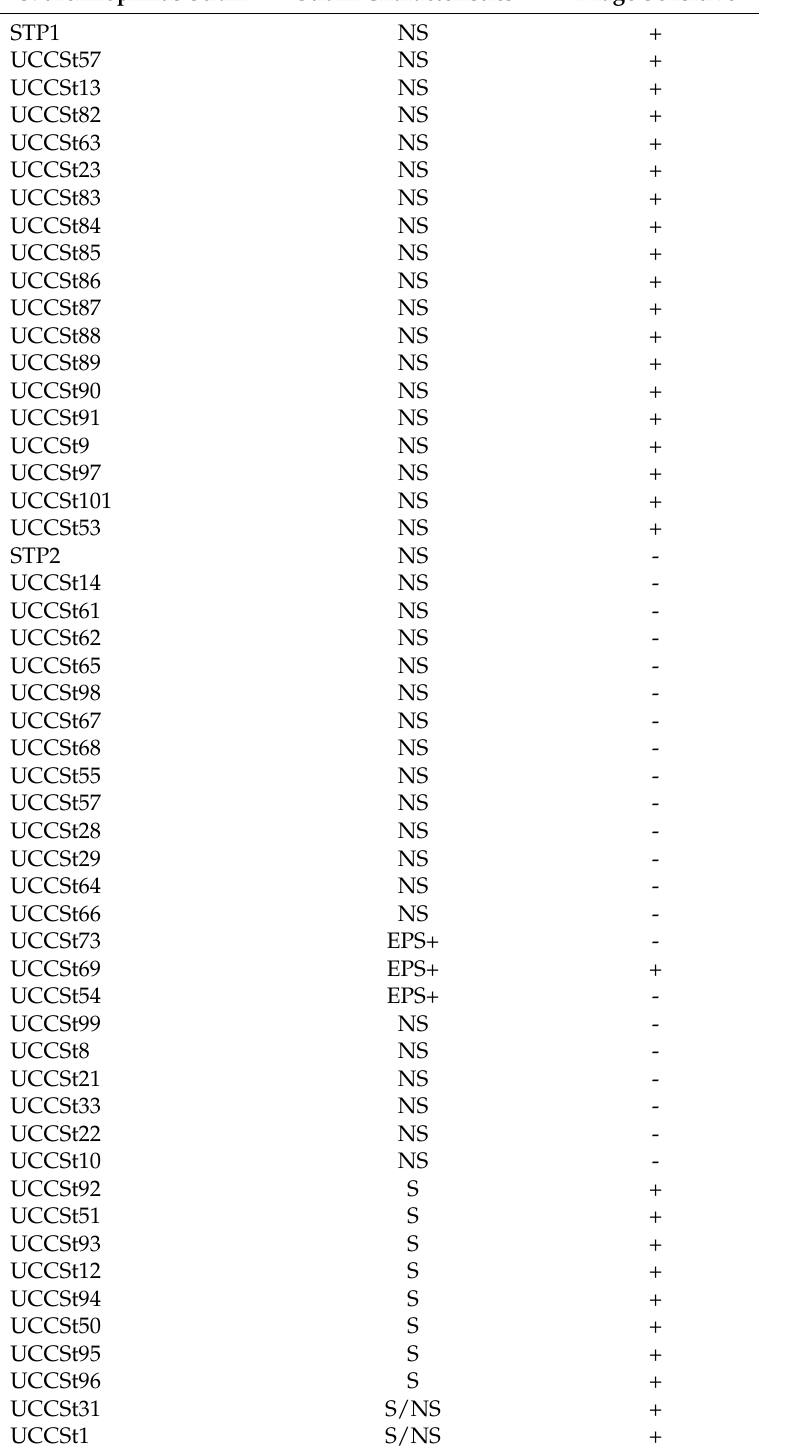
Table 1. Bacterial strains used in this study and their phenotypic